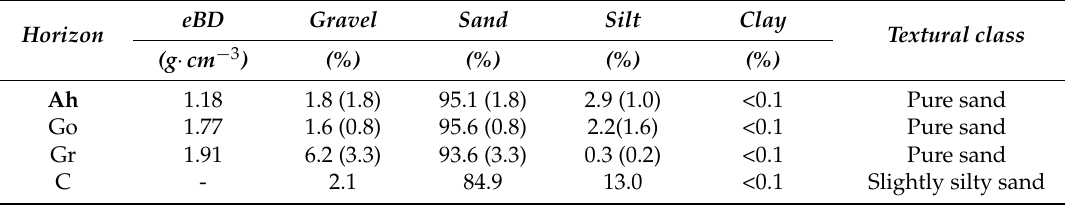
Table 1. Bulk density ( eBD ) and fractions of gravel, sand, silt, and clay for each horizon. Standard deviations are given in parentheses. Textural classes correspond to the German classification system